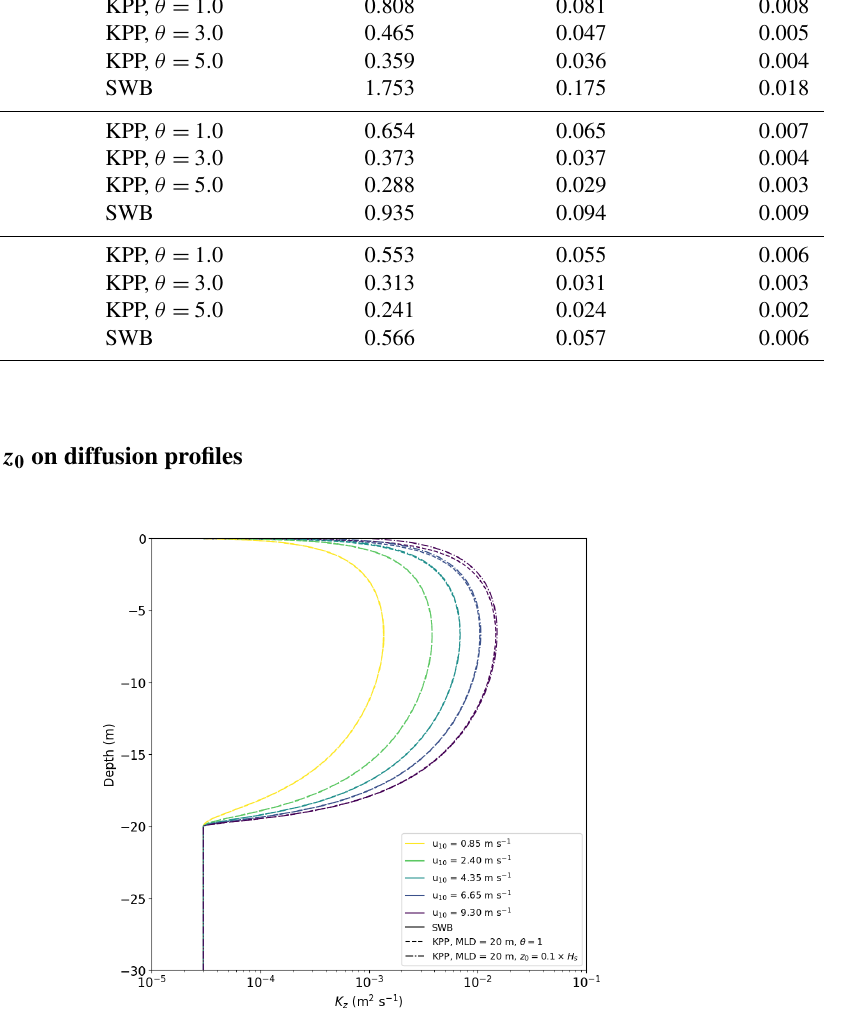
Figure B1. Vertical diffusion coefficient profiles for KPP diffusion under varying wind conditions with θ = 1 . 0. The KPP diffusion profile is calculated with either z 0 according to Eq. (12) or z 0 = 0 . 1 × H s